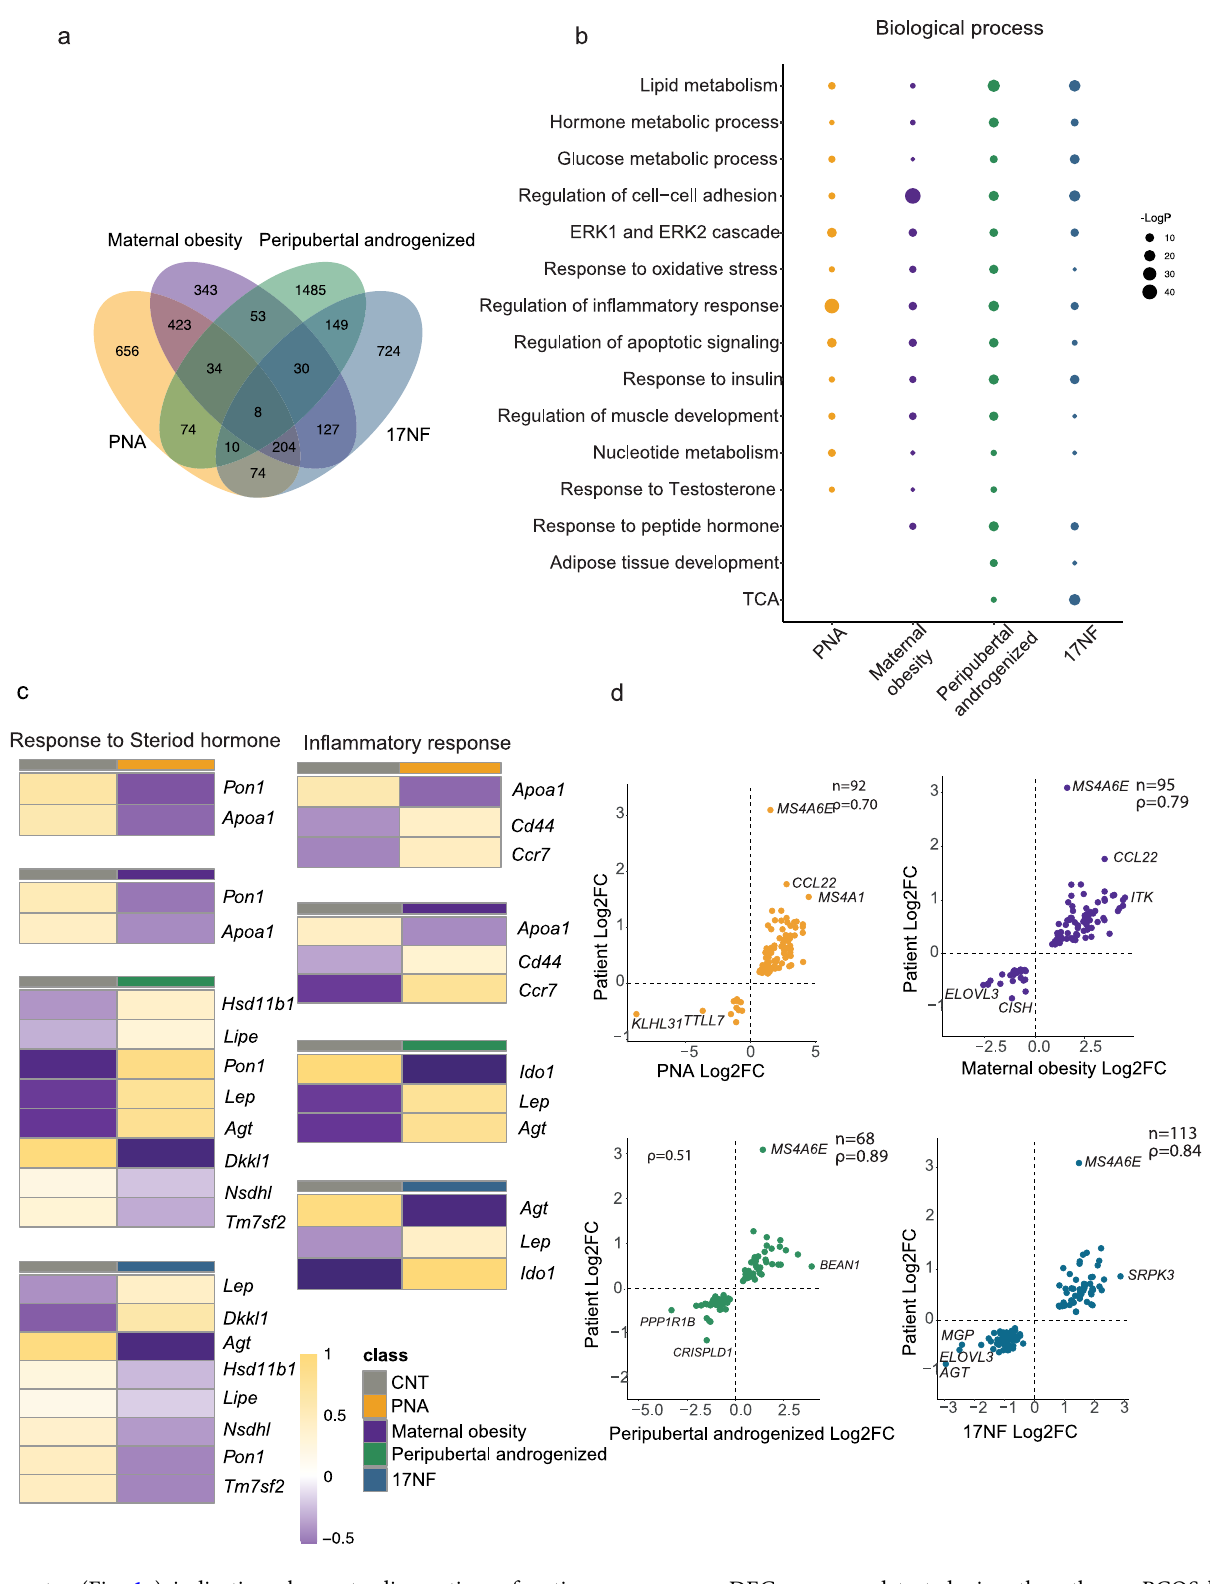
adipocytes (Fig. 1a) indicating aberrant adipose tissue function and metabolic dysfunctions. Transcriptomic analysis of sub- cutaneous adipose tissue showed common and unique DEGs (Fig. 6a and Table S8). The largest number of DEGs (1910) was found in the peripubertal androgenized model suggesting potent adult programming of DHT in adipose tissue (Fig. 6a). Total, 18